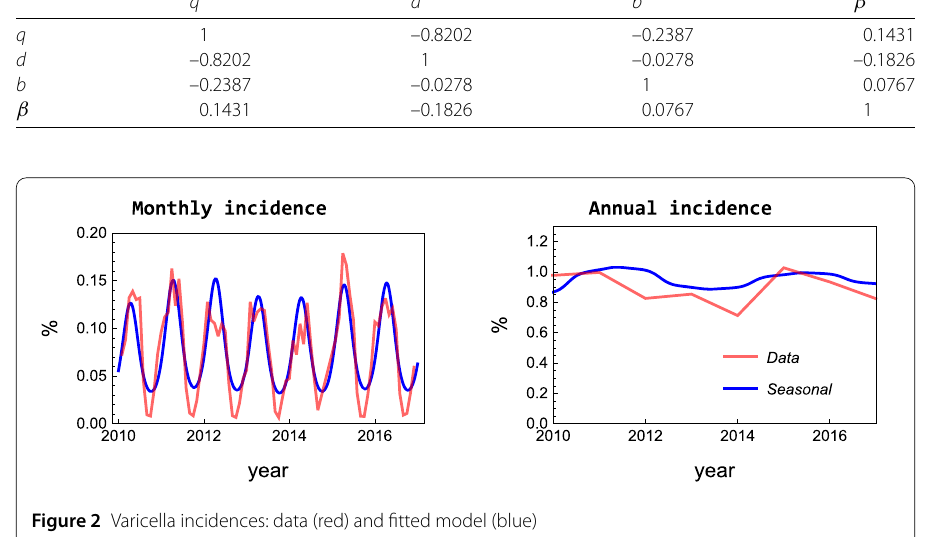
Figure 2 Varicella incidences: data (red) and fitted model (blue)